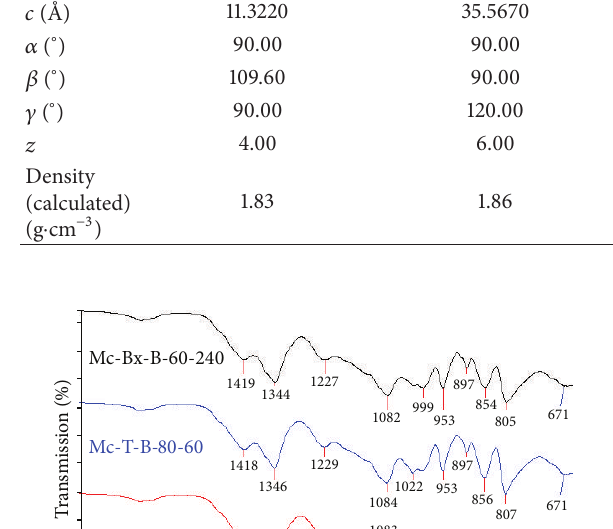
Figure 4: Raman spectra of pure admontite